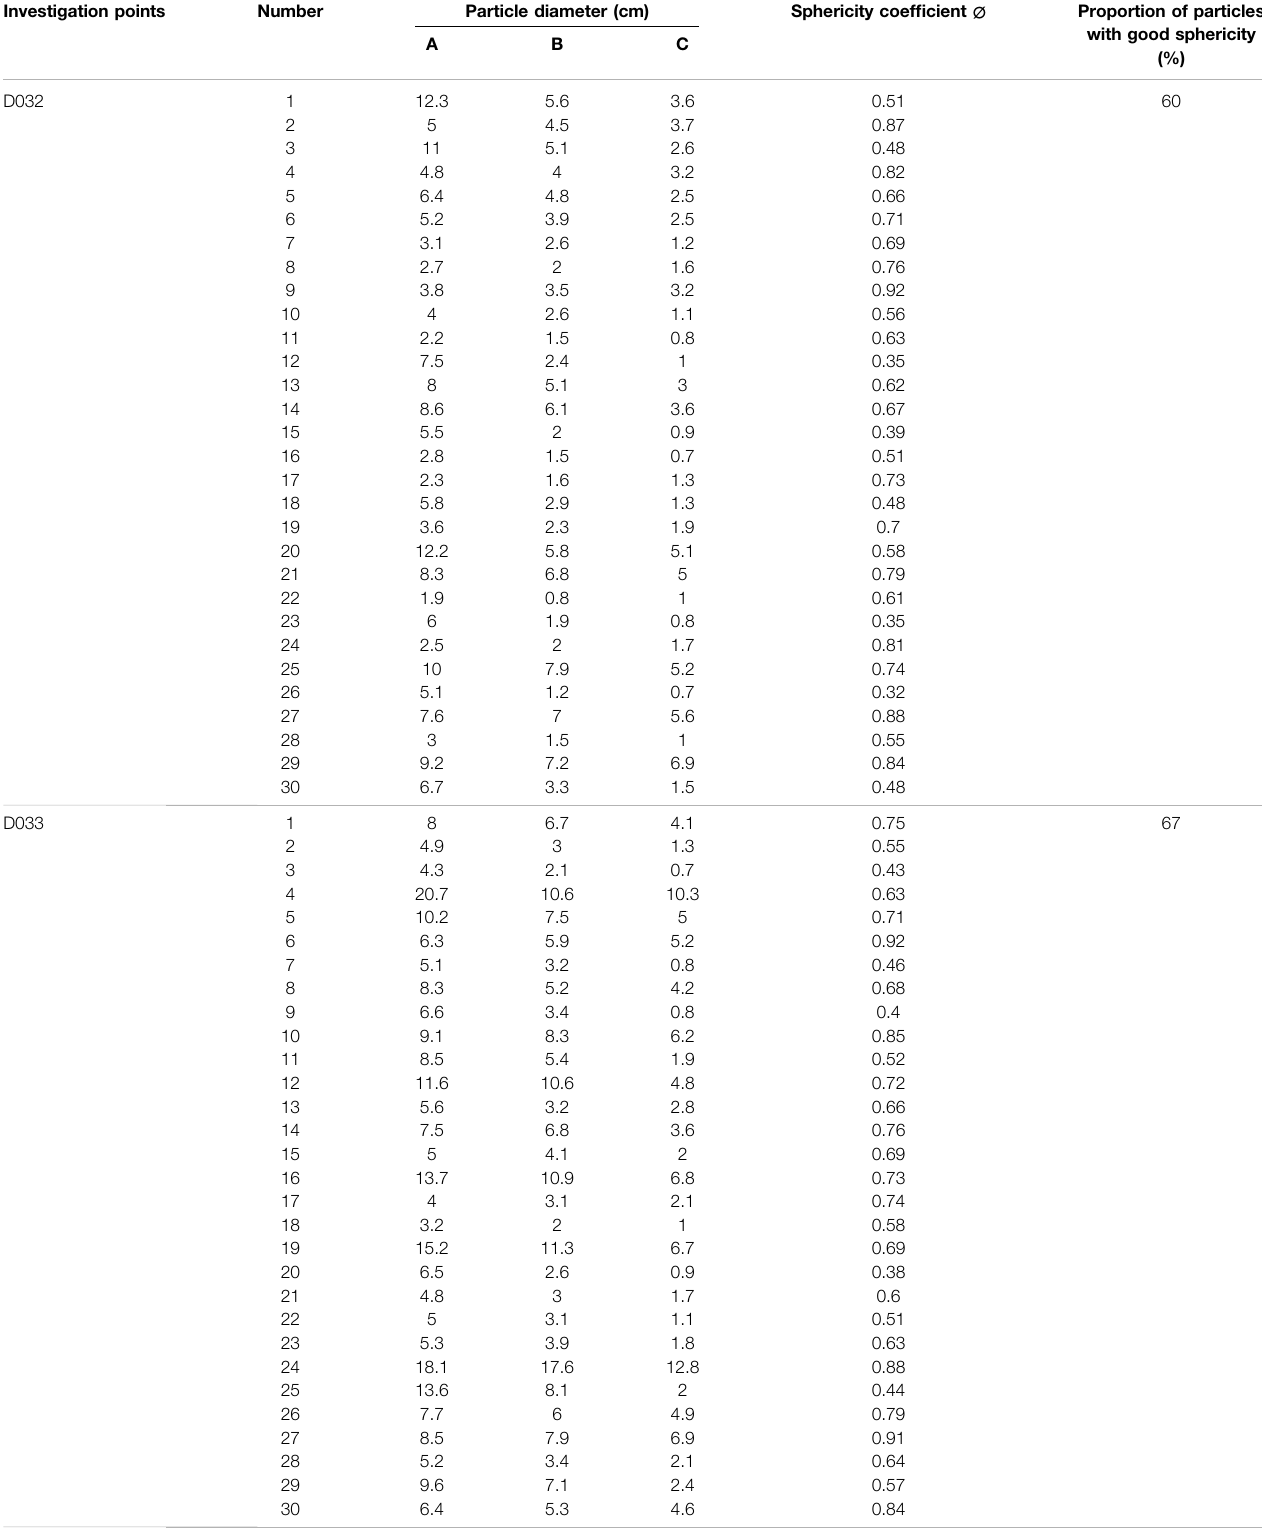
TABLE 1 | Sphericity investigation of basalt clastic particles. Investigation